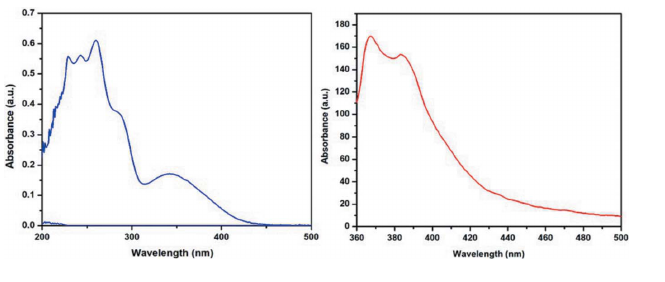
Figure 4 Absorption and emission spectra of the title compound 1 in DCM. The emission spectrum was excited at 350 nm.